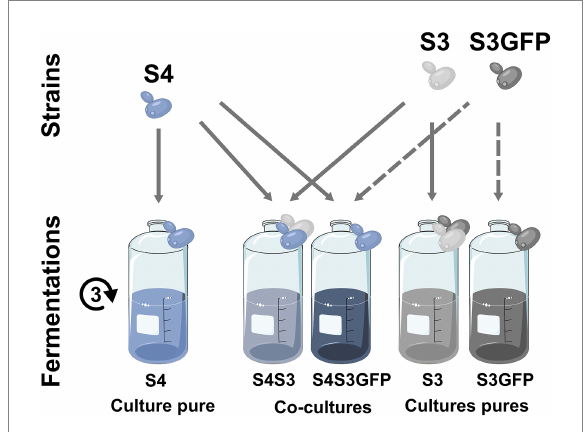
FIGURE 1 Experimental design. Experimental design and sample generation for the S4S3